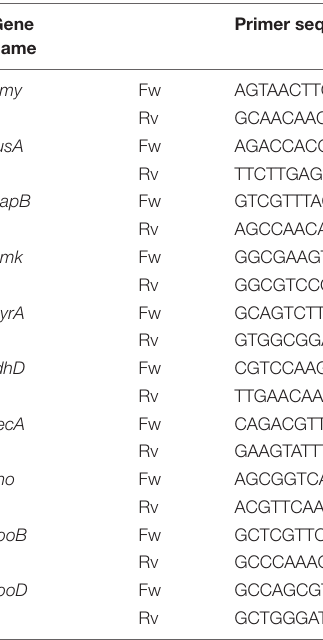
TABLE 2 | Oligonucleotide primers used in this